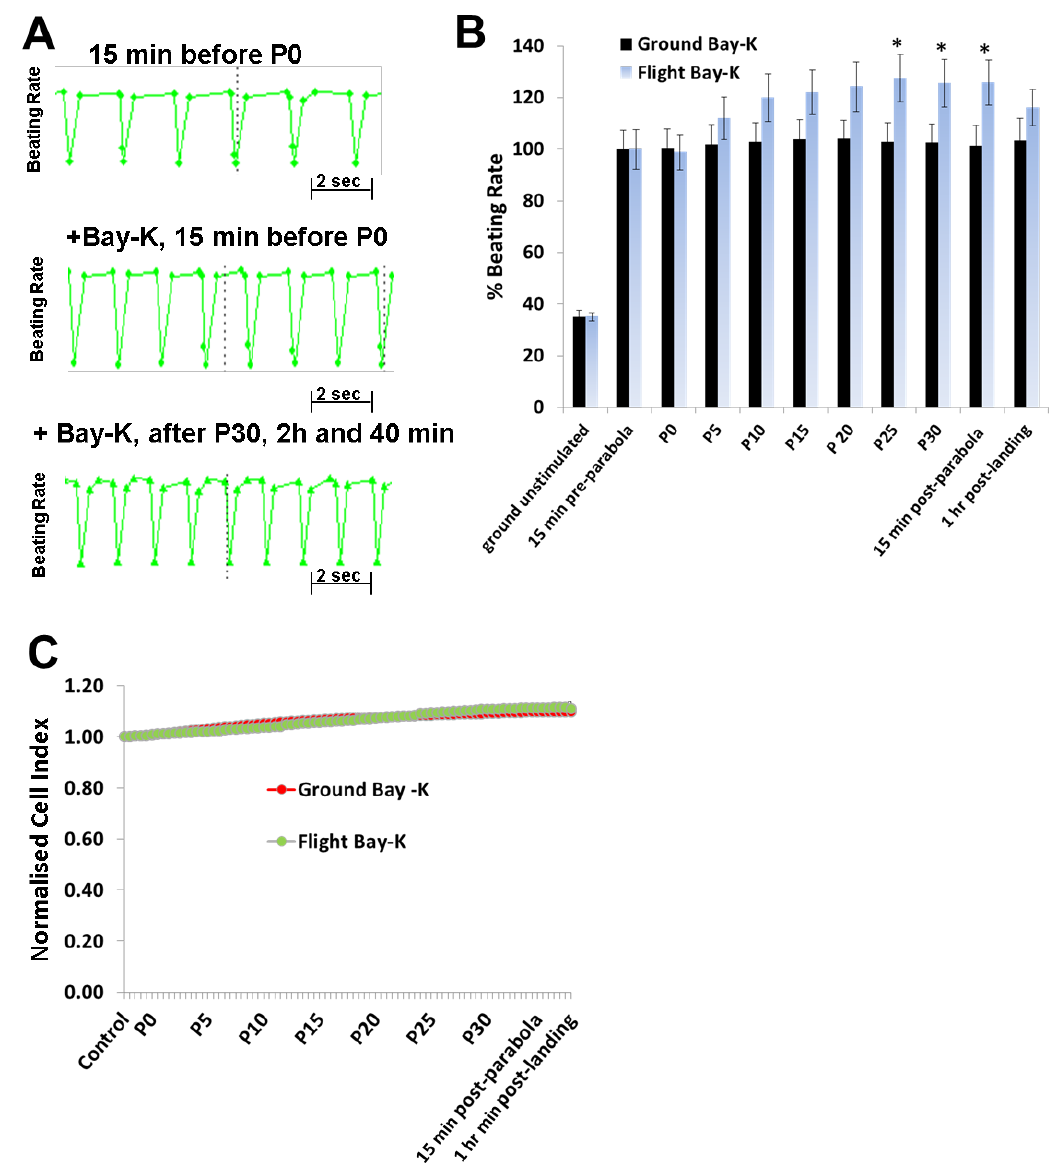
Figure 4. Analysis of the beating rate (BR) of human cardiomyocytes (hCMs) stimulated with Bay-K8644 (Bay-K; 1 µM) during the parabolic flights experiments ( A ) Upper panel: Representative BR pattern of unstimulated hCMs recorded 15 min (1 g ) prior to the first parabola (P0); Middle panel: Representative BR pattern of hCMs when stimulated with agonists 40 min prior to P0 and monitored 15 min before starting parabola P0. Lower panel: Representative BR pattern of hCMs stimulated 40 min prior to P0 and monitored again after 31 parabolas. ( B ) Data from three independent parabolic flight experiments, each executed in triplicate, as well as data collected from 1 g ground experiments carried out in parallel. The BR values were normalized by setting the Bay-K-induced BR of the ground control experiments prior to P0 to 100% (mean ± SEM, n = 9, * p < 0.05 for the ISO control values versus the Bay-K parabolic flight values). ( C ) Parallel monitoring of the cell viability expressed as the cell index (CI). The CI values were normalized by setting the control values to 1. SEM, standard error of the mean.